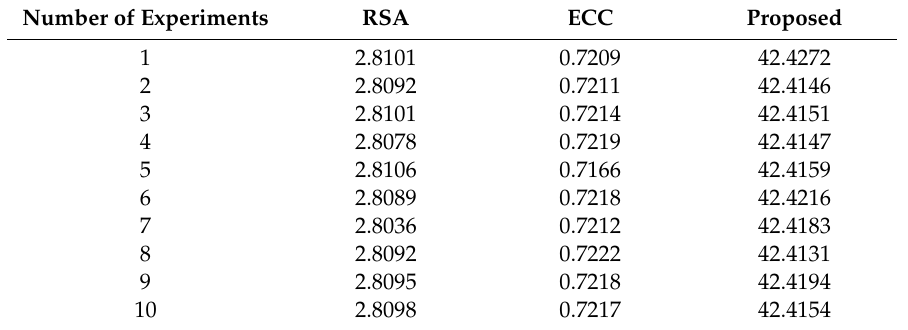
Table 2. Elapsed time (ms) to find private keys when using RSA, ECC, and the proposed algorithms.